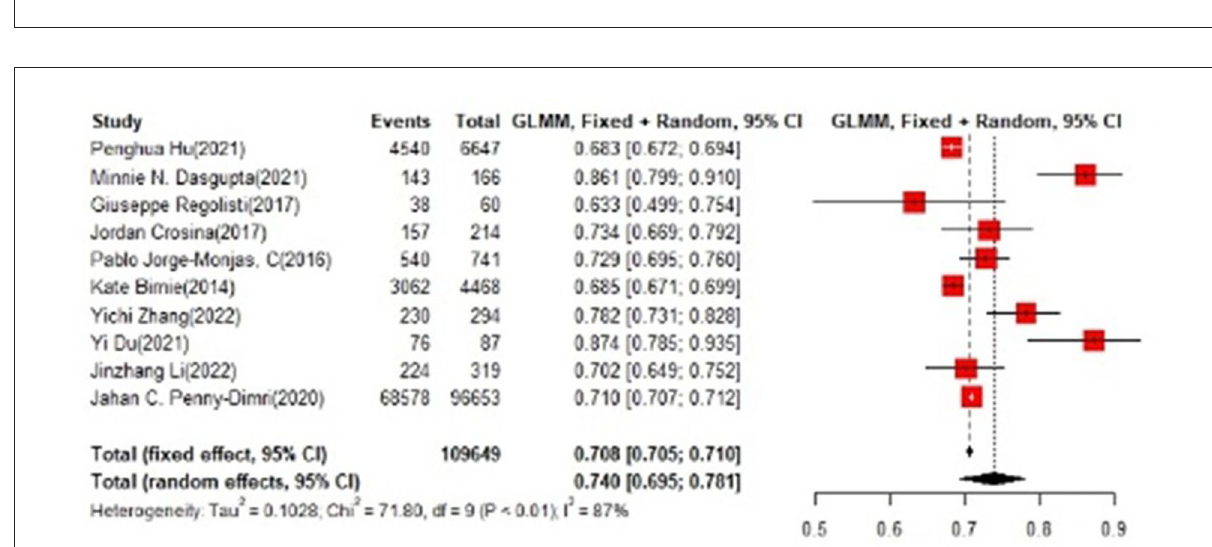
FIGURE4 Accuracy of the machine learning-based model in the training set: other models.